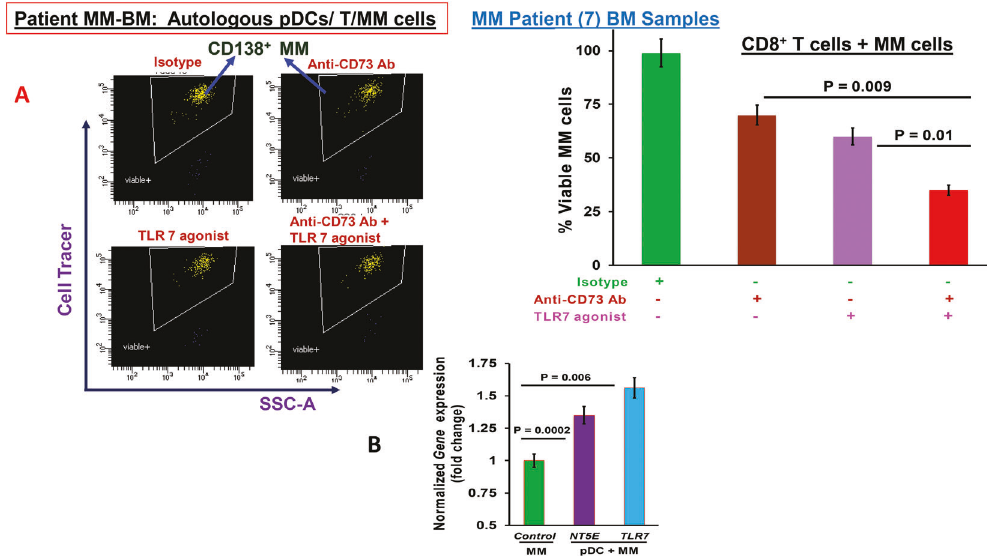
Fig. 6 Combination of anti-CD73 Ab and TLR-7 Agonist enhances T cell-mediated MM-speci fi c cytotoxic activity. A MM patient ( n = 7) BM C8 + T cells were co-cultured for 3 – 5 days with autologous pDCs (1 pDC: 10T cells) in the presence of isotype control Ab, anti-CD73 Ab, TLR-7 agonist, or anti-CD73 Ab plus TLR-7 agonist. Cells were washed and resuspended in a complete medium without drugs, and then cultured with autologous MM cells (10 T: 1 MM cell) pre-stained with CellTrace violet for 24h, followed by 7-AAD staining and FACS analysis to quantify CTL- mediated MM cell lysis. Left panel: representative FACS scatter plot shows a decrease in number of viable CellTrace Violet-positive MM cells. MM cells were also cultured alone without immune effector cells for 24h, and viability data obtained from fl ow analysis was used for normalization and account for spontaneous MM cells death. Right panel: bar graph shows quanti fi cation of CD8 + CTL-mediated MM cell lysis, re fl ected in % Viable MM cells under different treatment conditions, using data obtained in left panel. Percentage of viable MM cells for each treatment versus control (isotype-Ab) is presented. B Bar graph shows normalized NT5E/CD73 and TLR-7 gene enrichment in pDC-MM cell co-cultures versus MM cells